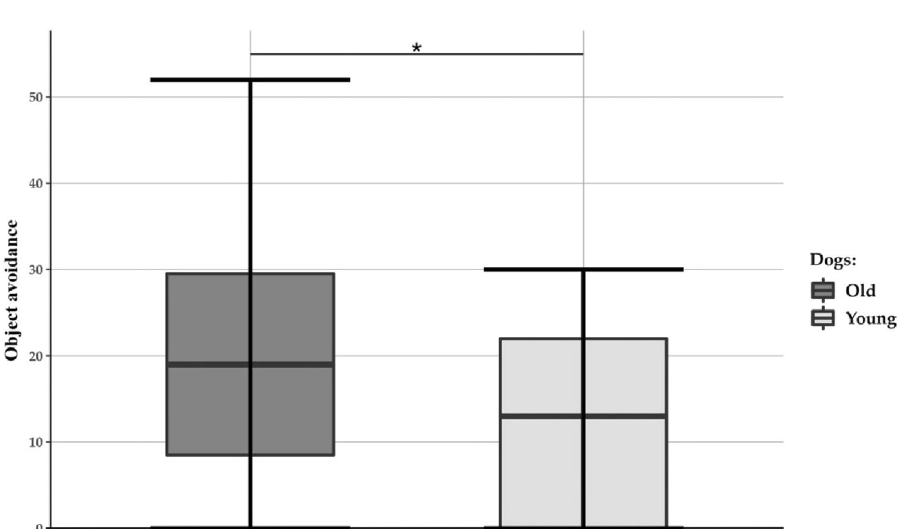
Figure 3. Object avoidance in the Novel object (toy dog) test. The old dogs avoided the toy for a larger proportion of time compared to the young dogs. A breakdown of the percentage of time spent avoiding the toy, divided by age group, is presented in the figure. The middle line in the box plots represents the median proportion of time spent avoiding the toy, the extremes of the boxes represent the lower and upper quartiles, and the error bars represent the minimum and maximum proportion of the time. The asterisk indicates a statistically significant difference between the groups (* = p <